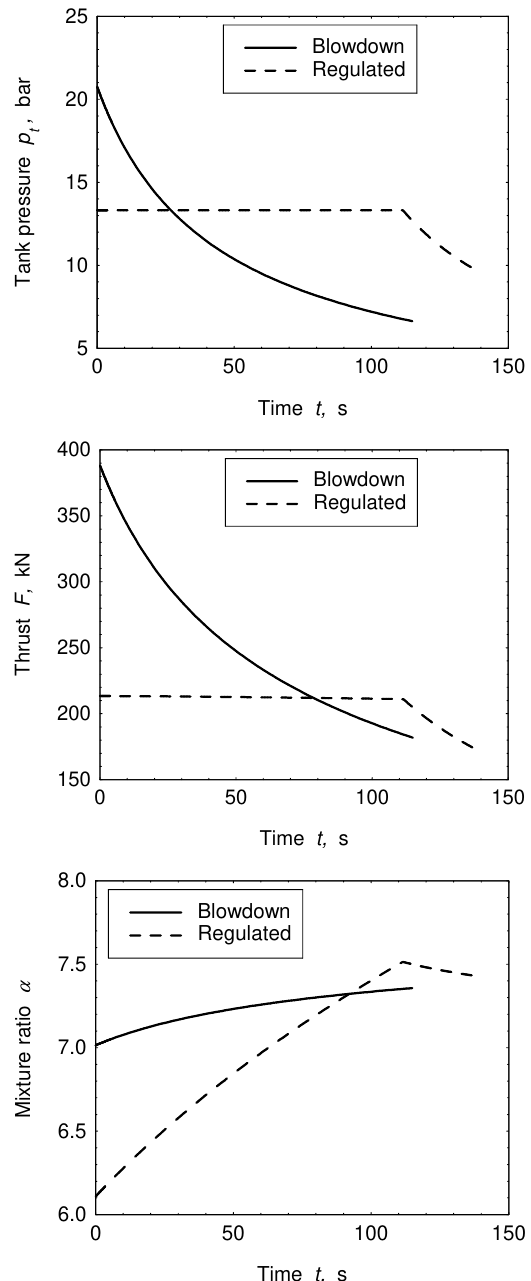
Figure 6. Tank pressure ( p t ), thrust level ( F ) and mixture ratio ( α ) during upper stage operation. The use of the blow down feed system results in a large thrust level variation during engine burn. Thus, a really high initial tank pressure is mandatory, in order to maintain a sufficient thrust until the end of the engine burn, also avoiding an increase in pressurizing gas mass. A performance improvement is obtained employing a partially regulated feed system: the introduction of an auxiliary pressurizing gas tank is balanced, in terms of engine dry mass, by the reduction of the oxidizer tank mass due to the lower